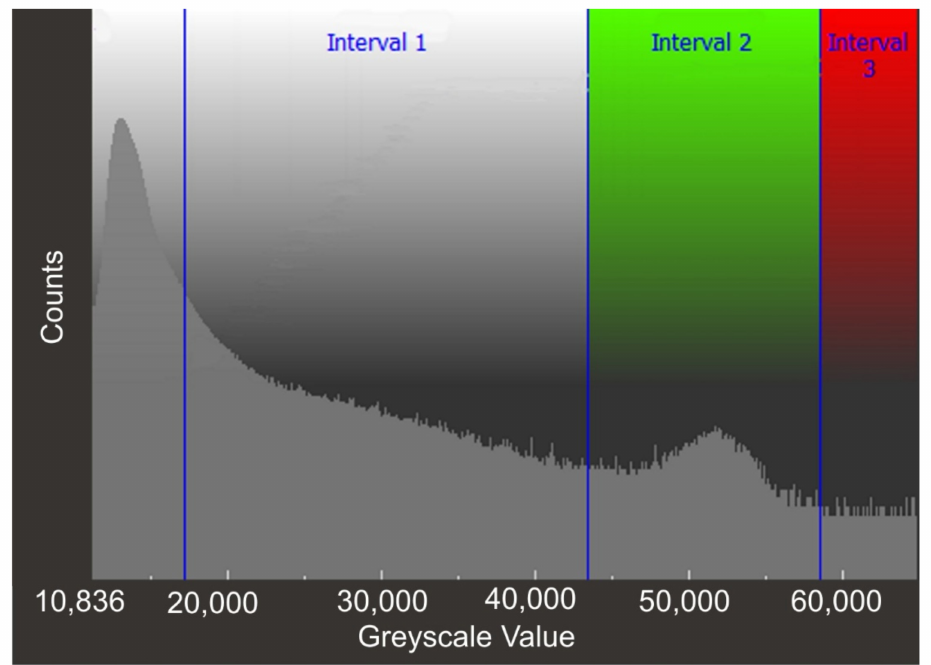
Figure 2. Diagram showing the initial segmentation used to select the greyscale values associated with the fracture filling material of the glass-filled ruby. It is a density separation. Interval 1 (grey) peak is the bulk host gem material and Interval 2 (green) peak is the filler. Interval 3 is filler-related denser